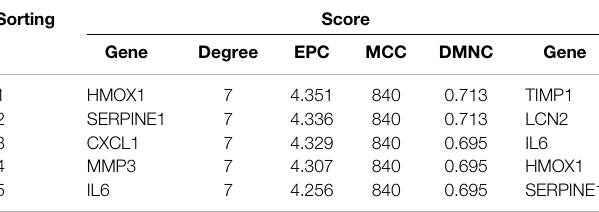
TABLE 2 | Scores for the top fi ve hub gene in functional cluster 1